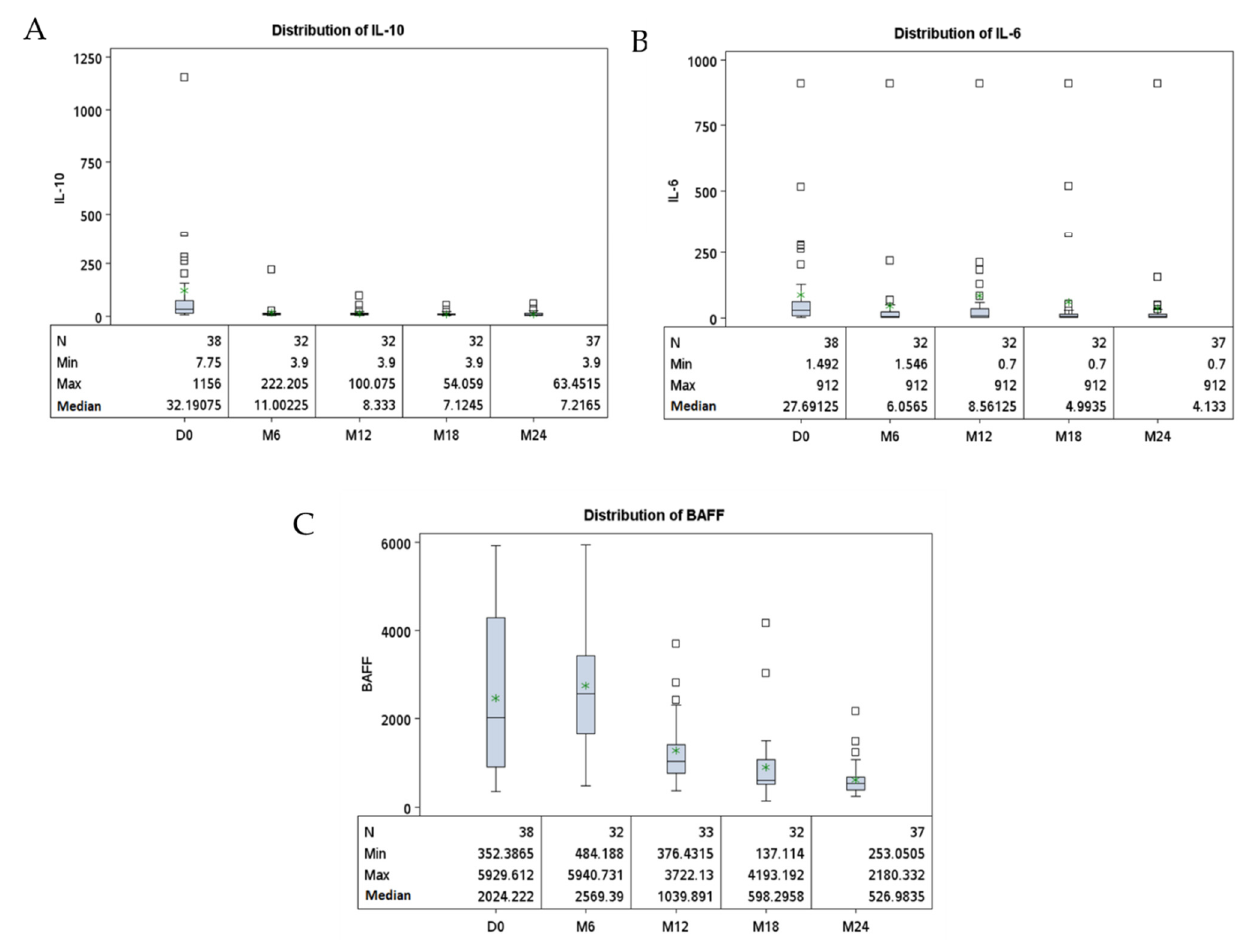
Figure 1. Longitudinal distribution of serum markers in HIV-positive cHL patients. Legend: Each panel represents the distribution of serum levels (pg/mL) of IL10 ( A ), IL6 ( B ) and BAFF ( C ) collected every 6 months during 24 months.*: mean; D: day; M: month. In the 7 patients with available pre-cHL diagnostic serum samples (Supplementary Tables S1 and S2), the median IL10 serum level was lower prior to cHL diagnosis ( p =